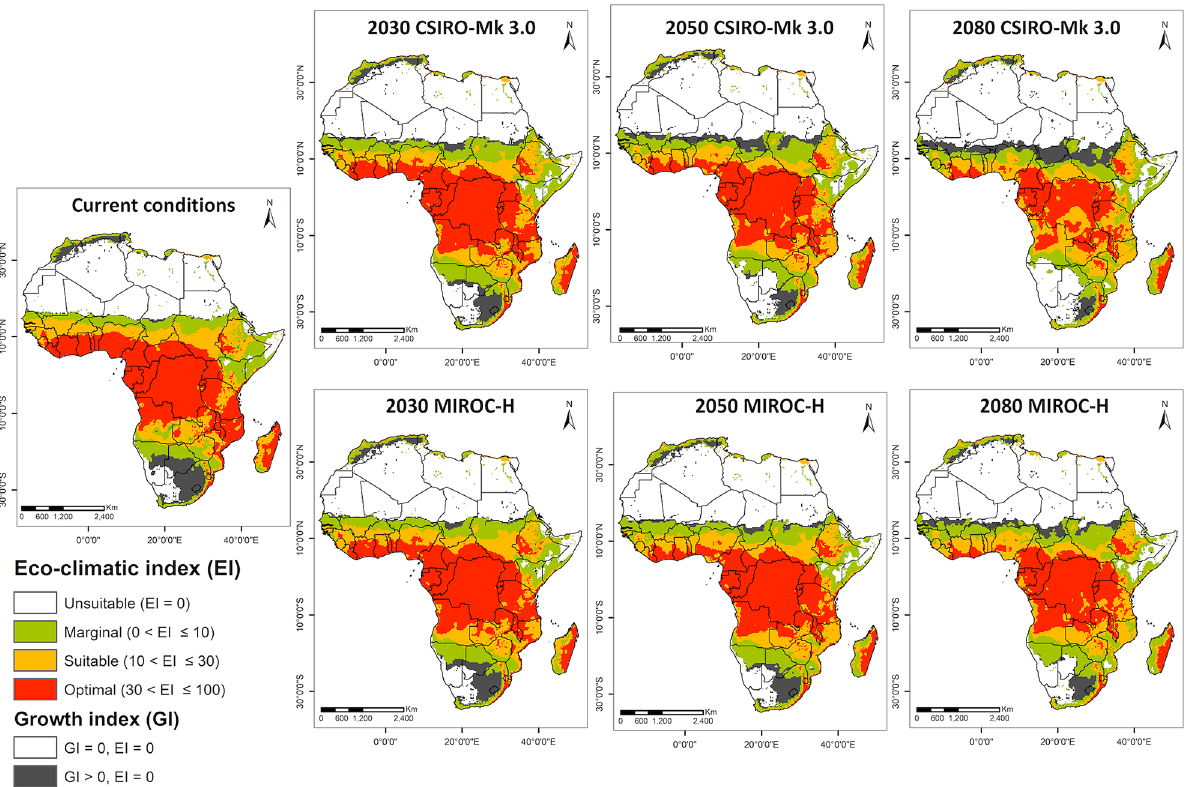
Figure 4. The climatic suitability areas for FAW population establishment and seasonal population growth, considering irrigation scenario II. These projections were based on the current and projected future climates (2030, 2050 and 2080) under CSIRO-Mk3.0 (top) and MIROC-H (bottom) GCMs. Areas with EI > 0 support FAW year-round population establishment, areas with EI = 0 but GI > 0 support FAW seasonal population growth and areas with EI = 0 and GI = 0 are unsuitable for FAW survival. ArcMap 10.8 (https:// deskt op. arcgis. com/ en/